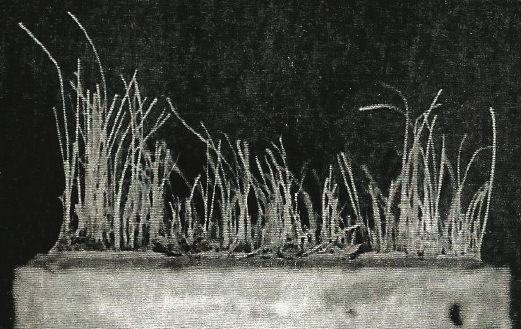
Figure 1. Fracture profile of a 45 mm fiber reinforced specimen.